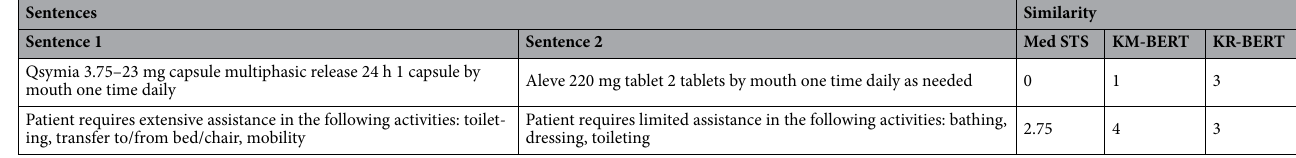
Table 4. Examples of the MedSTS dataset containing the true MedSTS similarity and similarities measured by KM-BERT and KR-BERT. Sentences were translated from the original English MedSTS sentences into Korean.